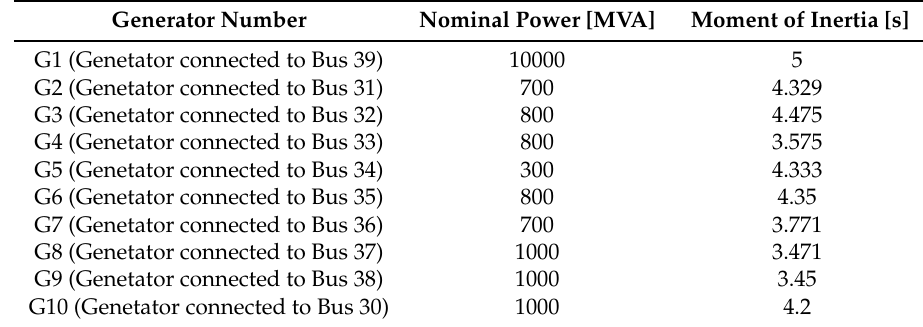
Table 3. IEEE 39-bus test system synchronous generator data.